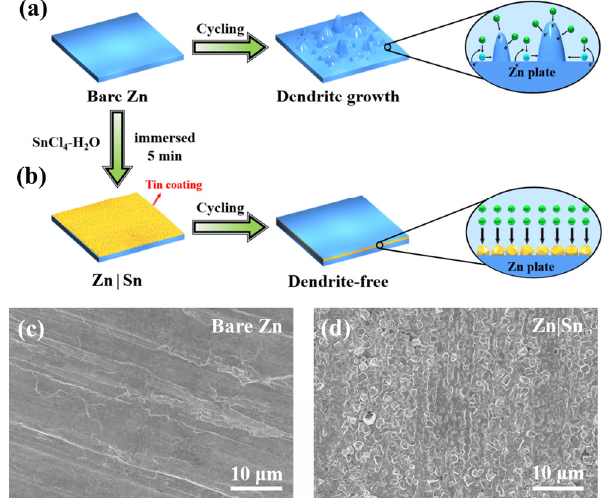
Figure 1 Schematic illustrations of the Zn|Sn anode fabrication process and the behavior of (a) bare Zn and (b) Zn|Sn during cycling. SEM images of (c) bare Zn and (d)